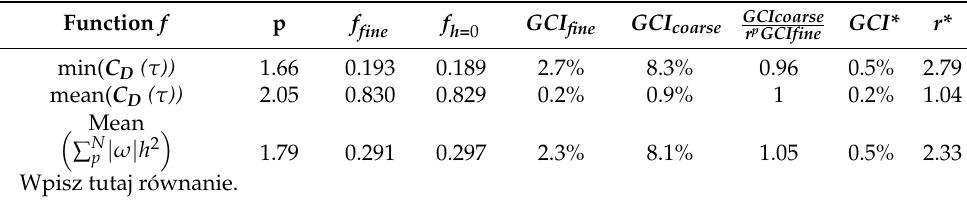
Table 3. Grid convergence